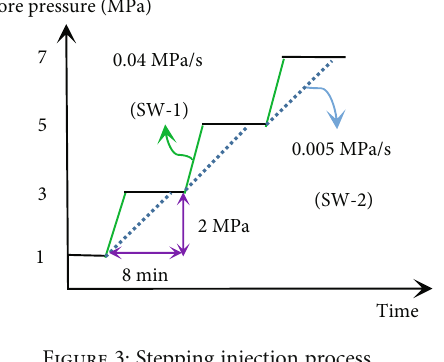
Figure 3: Stepping injection process. Table 1: Experimental program and parameter setting. Test